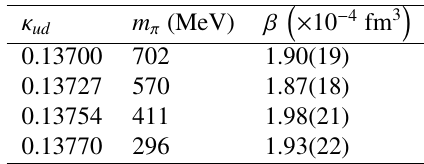
Table 1. Lattice magnetic polarisability values for the proton at each quark mass considered. The numbers in parentheses describe statistical